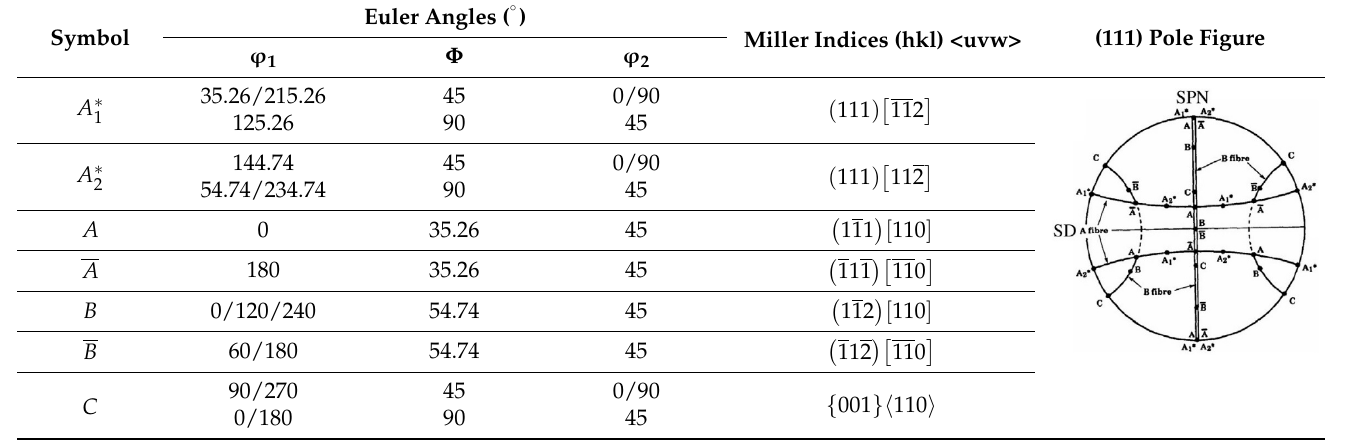
Table 1. Ideal texture components with corresponding Euler angles and miller indices in simple shear deformation of metals with a face centered cubic crystallographic structure [10,30].